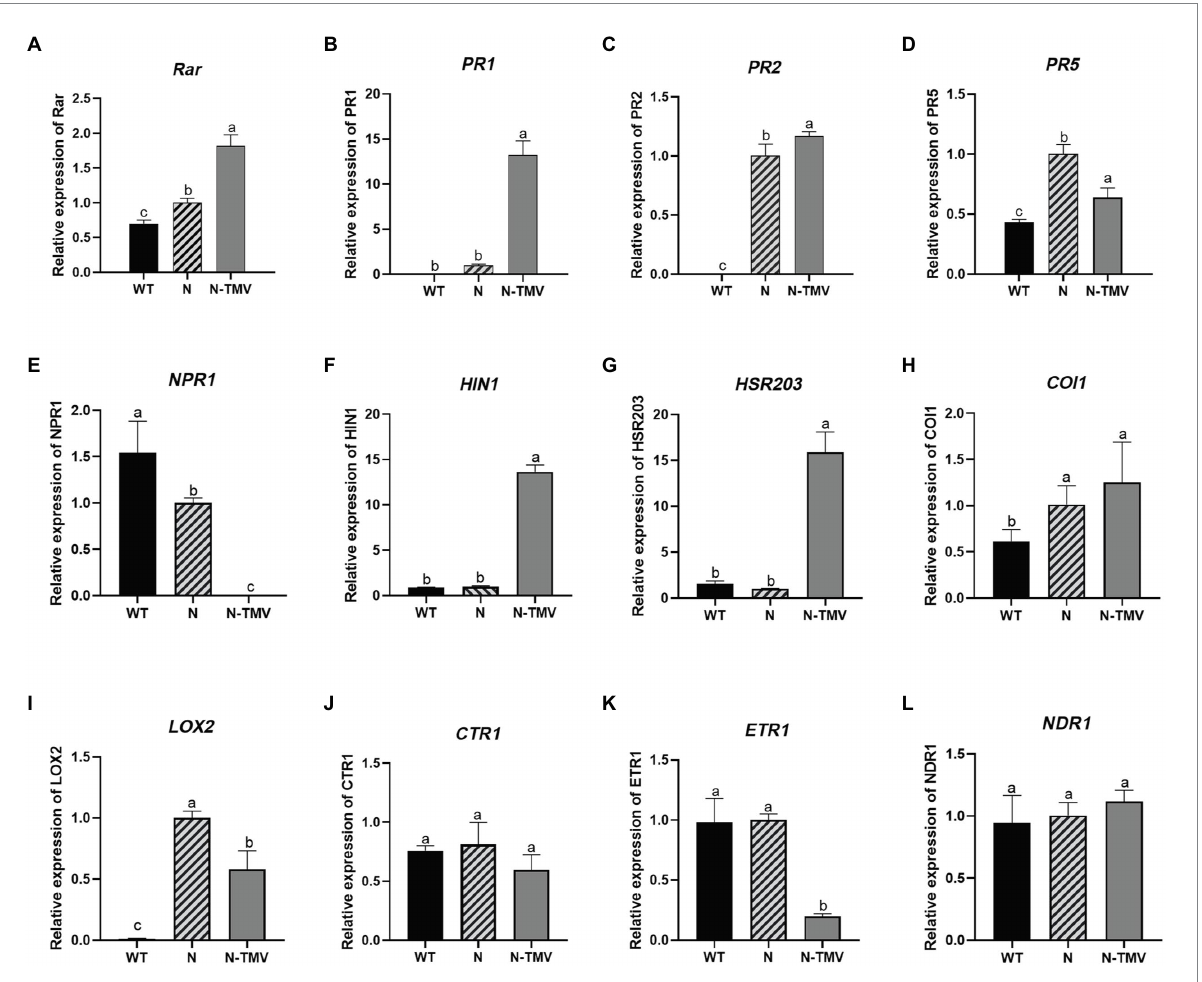
FIGURE 7 Gene expression analysis of defense genes and the key genes in disease resistance pathways by qRT–PCR. The gene expression levels of Rar (A) , PR1 (B) , PR2 (C) , PR5 (D) , COI1 (E) , LOX2 (F) , HIN1 (G) , HSR203 (H) , LOX2 (I) , CTR1 (J) , ETR1 (K) , NDR1 (N) in leaves of different treatment groups. Different letters in the same column pattern are significantly different from each other, followed by Duncan’s multiple range test to identify significant differences at p < 0.05. Vertical bars refer to the mean ± SD ( n =